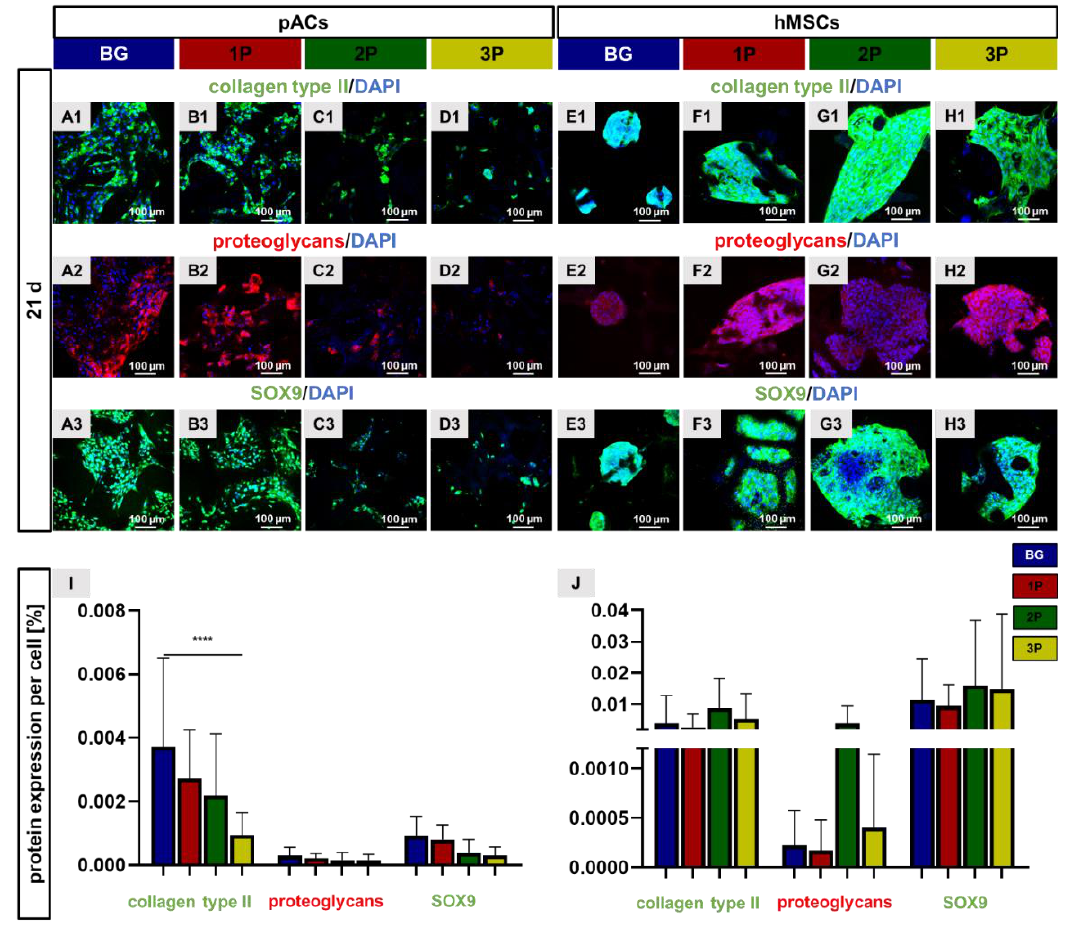
Figure 9. Cartilage-specific protein expression after 21 days of scaffold colonization. Representative immunocytochemical staining of collagen type II (green) and cell nuclei (blue) of pACs ( A1 – D1 ) and hMSCs ( E1 – H1 ), of cartilage proteoglycans (red) and cell nuclei (blue) of pACs ( A2 – D2 ) and hMSCs ( E2 – H2 ) and the transcription factor SOX9 (green) and the cell nuclei (blue) of pACs ( A3 – D3 ) and hMSCs ( E3 – H3 ). The calculation of the immunoreactivity (collagen type II, proteoglycans and SOX9) per cell was performed for pACs ( I ) and hMSCs ( J ). The pure bioactive glass (BG, blue), single (1P, red), twofold (2P, green) and threefold PLGA infiltrations (3P, yellow). Scale bar: 100 µ m. n = 3. One-way ANOVA (post hoc Tukey Test) for comparison between the groups. p values: **** p < 0.0001. pACs = porcine articular chondrocytes and hMSCs = human mesenchymal stem